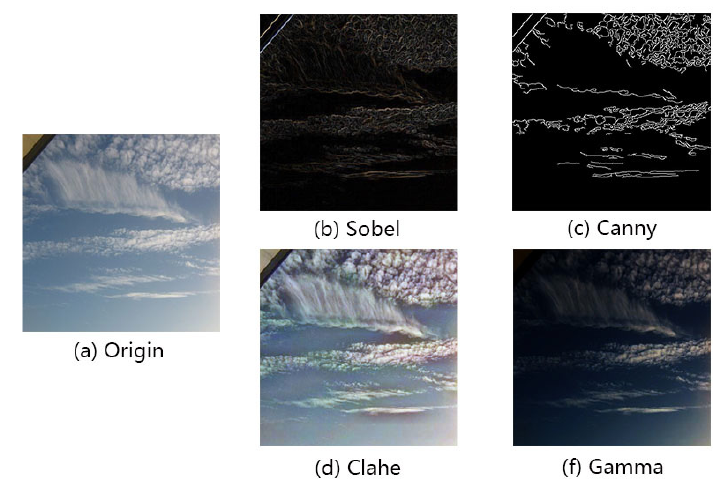
Figure 6. Original image and processed images.